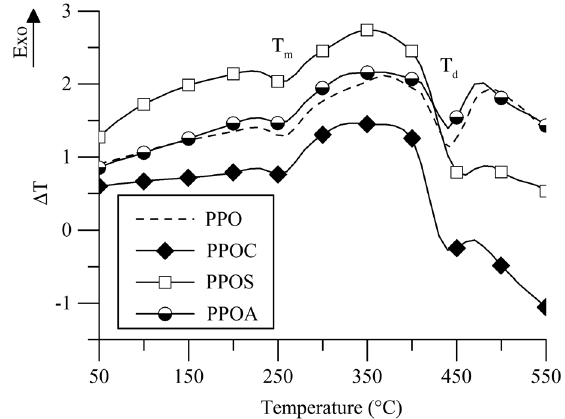
and T values of the investigated materials as a func- Figure 5 T max end tion of the filler amounts.